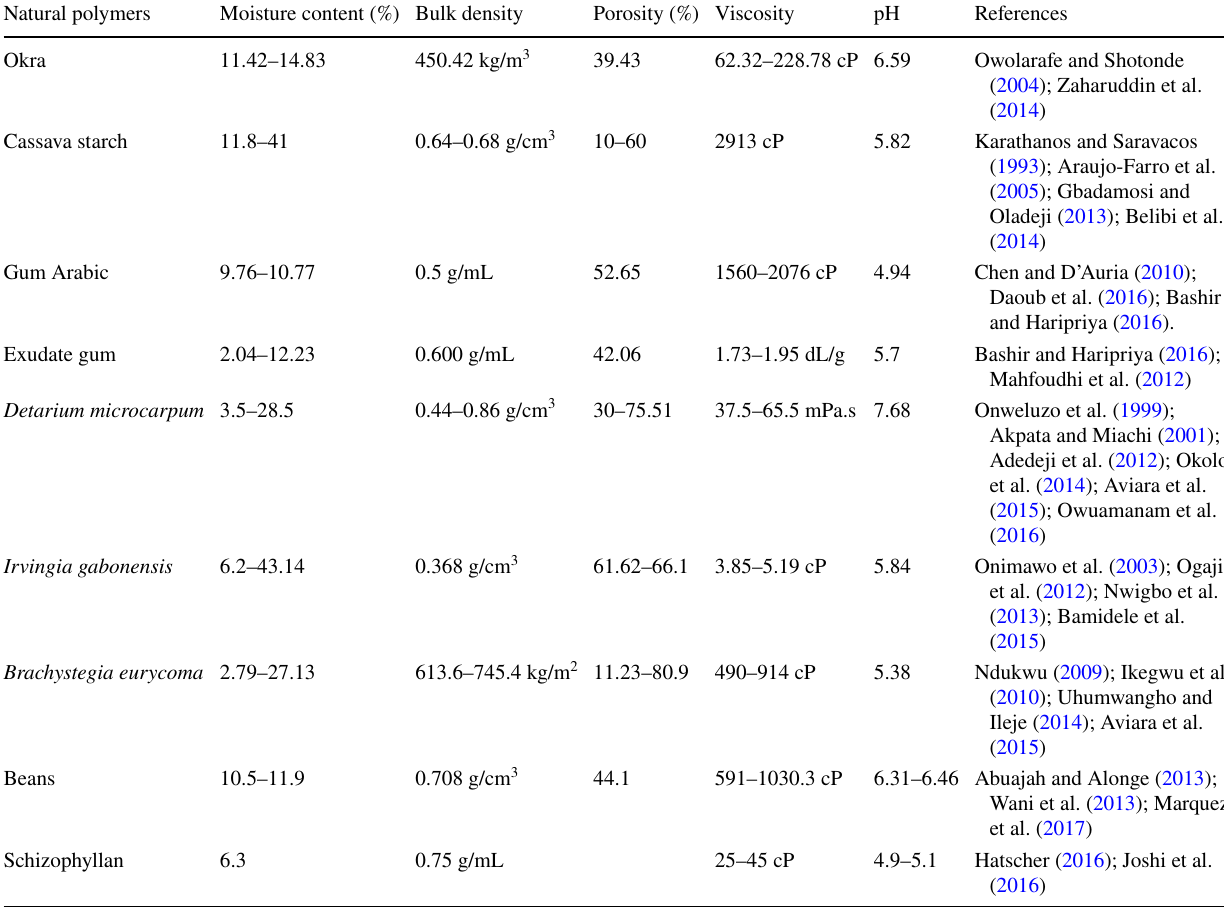
Table 1 Basic properties of natural polymers Natural